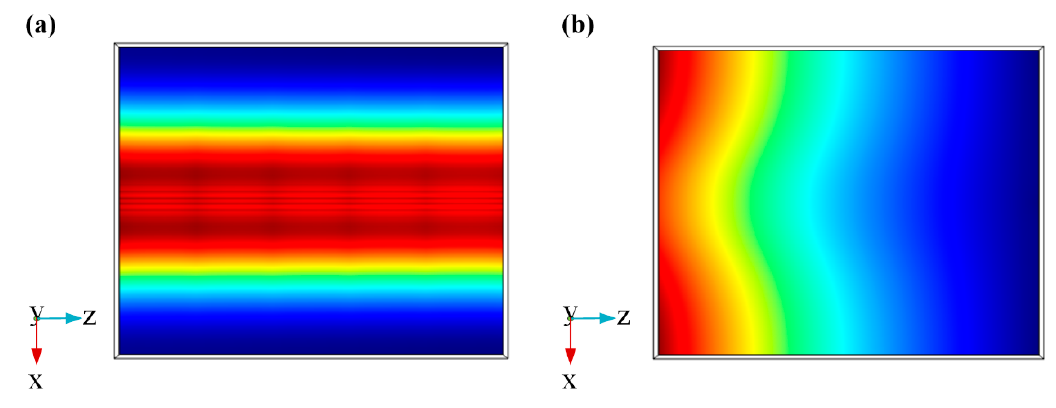
Figure 8. Multi section graph of GESMBOSN’s three-dimensional electric field in different external voltages: ( a ) 1.5 V ( b ) 2.3 V.